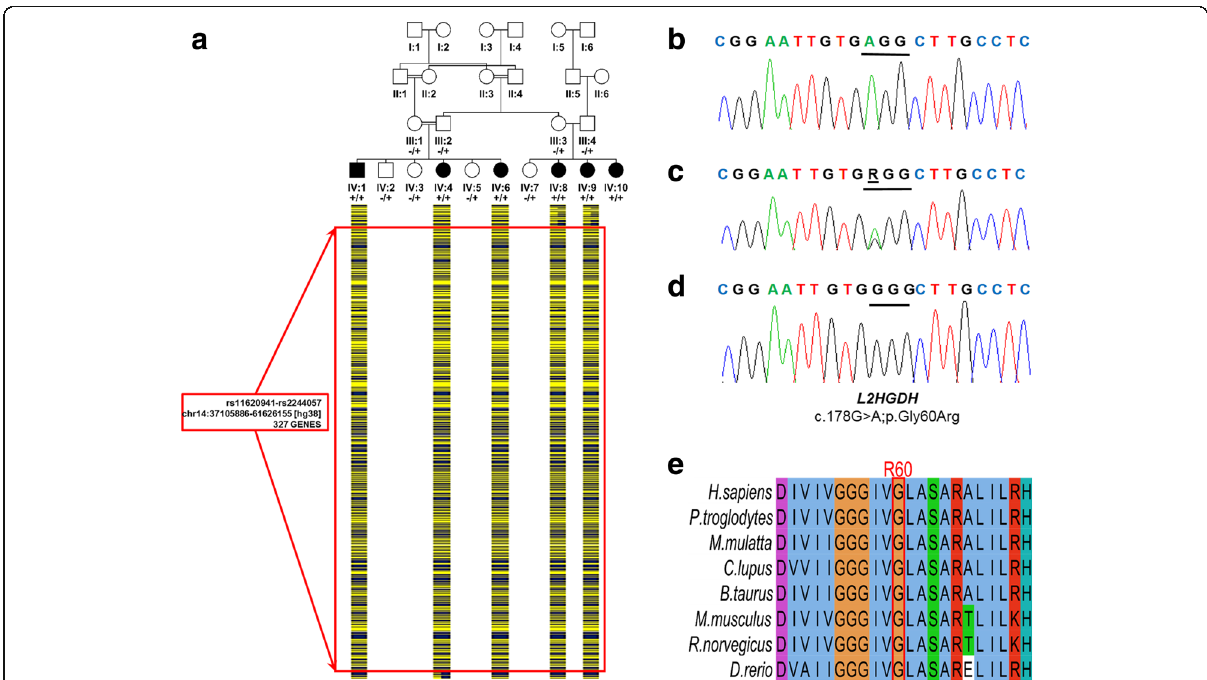
Fig. 2 Family pedigree showing L2HGDH c.178G > A genotype data and images of affected individuals. a Simplified pedigree of the extended Pakistani family investigated, with pictorial representation of genotypes across ∼ 24 Mb of chromosome 14 encompassing the disease locus (dashed blue boxed region, red boxed region). All affected individuals were subsequently shown to be homozygous for the L2HGDH variant NM_024884.2:c.178G > A (indicated). Parental samples were heterozygous, and unaffected siblings were either WT or heterozygous carriers. b-d Electropherograms showing the DNA sequence at the position of L2HGDH c.178G > A in a homozygous affected ( b ), heterozygous father ( c ) and WT control ( d ) and amino acid alignment using ClustalW showing high conservation of the G60 residue across vertebrates ( e